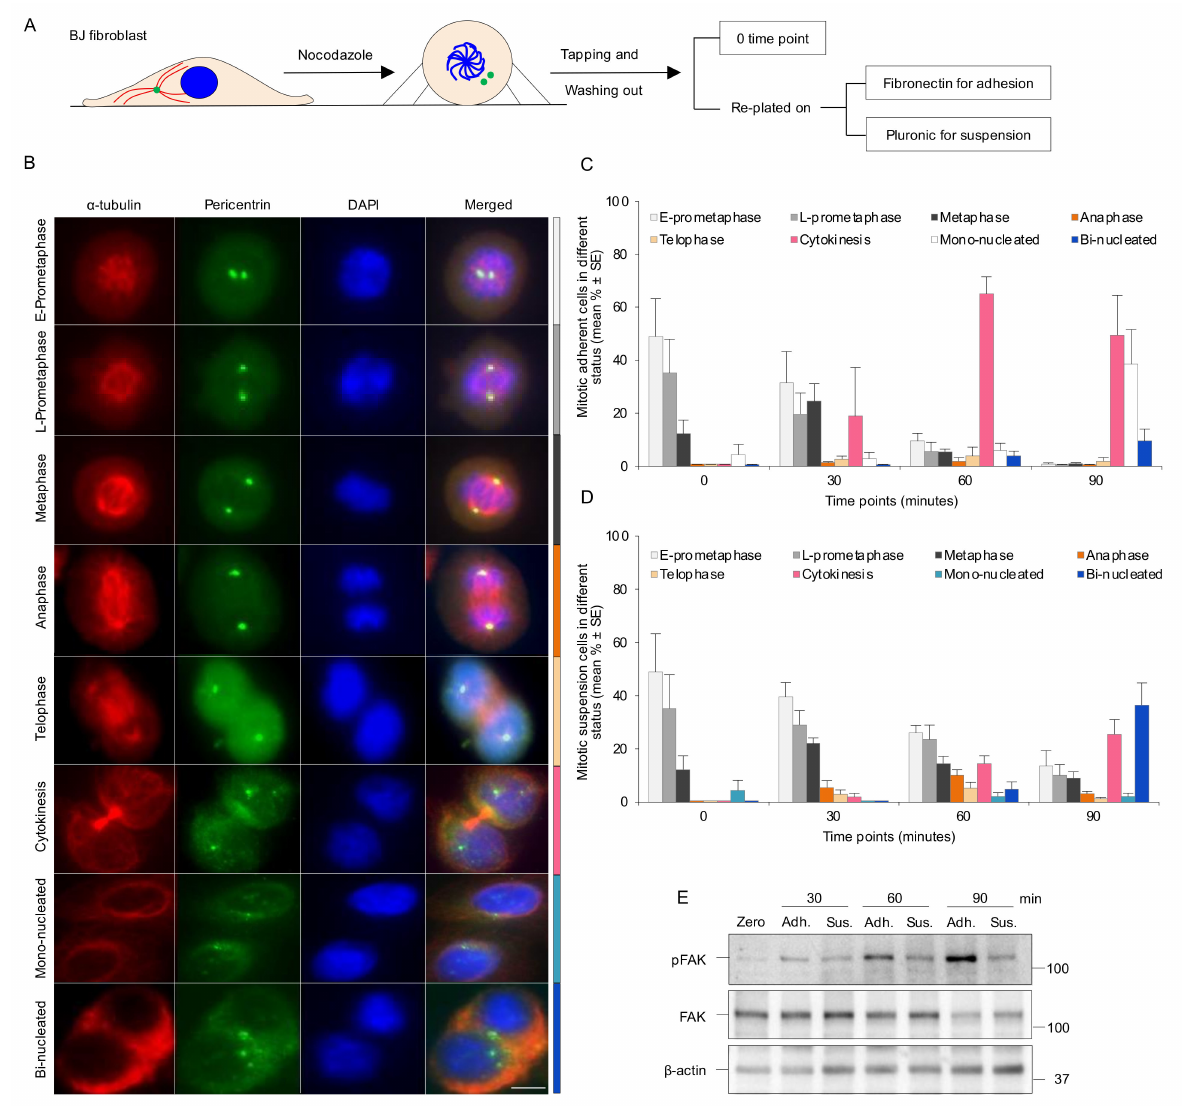
Figure 1. Absence of integrin-mediated cell adhesion causes a delay in the early mitotic progression. ( A ) Experimental design illustrating how the isolated mitotic cells were used to check mitotic pro- gression in the different culture conditions. Centrosomes, microtubules, and nucleus/chromosomes are shown in green, red, and blue, respectively. ( B ) Representative immunofluorescence micrographs illustrating the mitotic progression of BJ cells from early (E)- and late (L)-prometaphase to cytokinesis, the presence of divided cells (mono-nucleated cells), and the cells that failed to complete cytokinesis (bi-nucleated cells). The centrosomes and the mitotic spindle were labeled with antibodies against pericentrin (green) and α -tubulin (red) directly after nocodazole washout (0 min time-point) and after a 30, 60, and 90 min incubation period of the cells adhering to fibronectin or kept in suspension. Nuclei were stained with DAPI. Scale bar, 10 µ m. ( C , D ) Mean (%) ± SE of the number of adherent ( C ) and non-adherent cells ( D ) in different mitotic stages determined based on centrosomes’ location, spindle formation, and nucleus status as shown in part B. The color of each bar on the graph corre- sponds to the different mitotic phases shown in the side color bar of part B. ( E ) Western blot of the mitotic cells treated as in ( C , D ) to monitor the phosphorylation of FAK at Tyr397 and total FAK at the described time